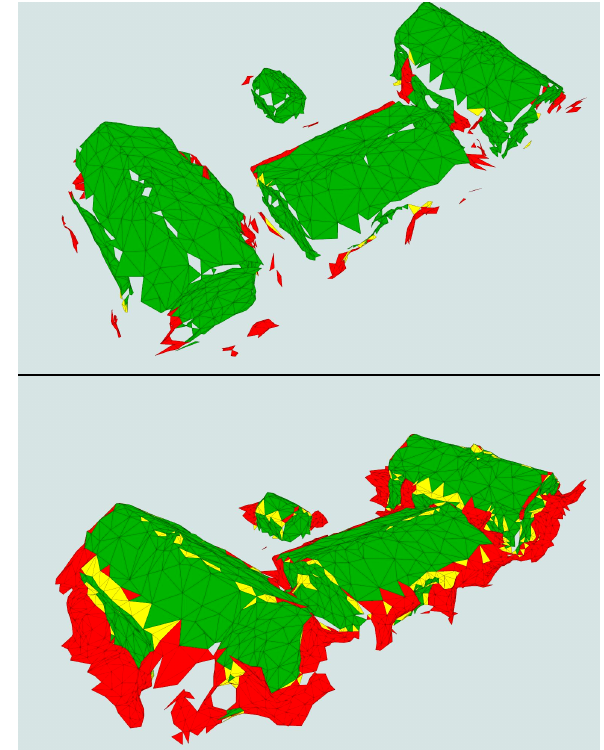
Figure 6. Comparison of the results of the point-to-plane (bottom) and volume distance measure (top). The point-to-plane results are colored according to Figure 3. The volume distance measure results are colored as